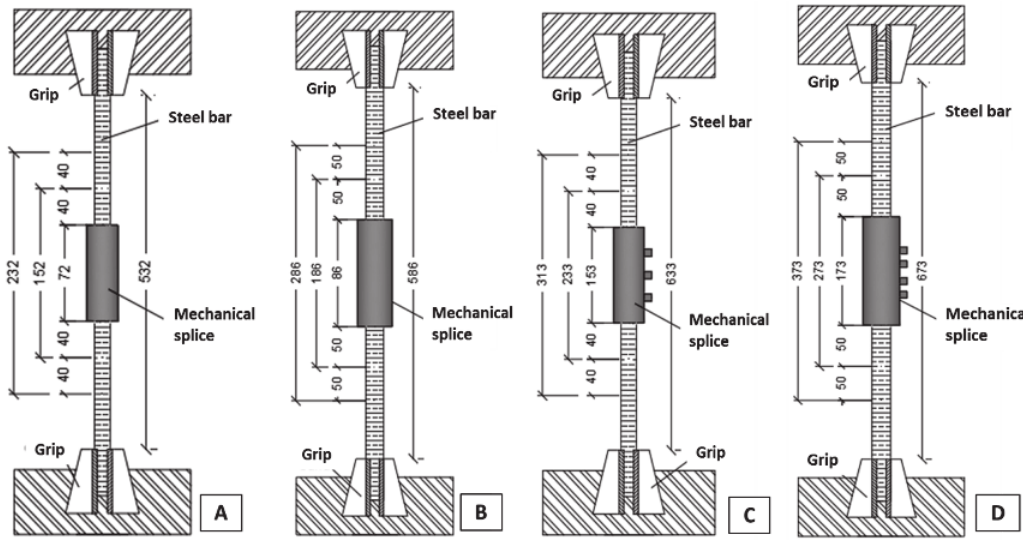
Sample sizes according to ISO 15835 [1]. A - taper-threaded sleeve 20 mm; B - taper-threaded sleeve 25 mm; C - bolted coupler 20 mm and D - bolted coupler 25